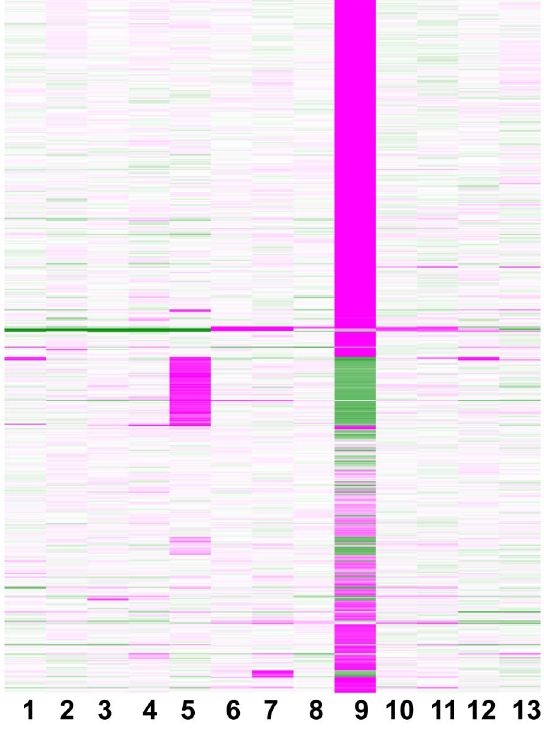
Figure 7. Transcript profiles of expressed Medicago DEFLs . Treatments were: (1) Germinating seed, (2) stem, (3) flower buds, (4) flowers, (5) seed, (6) uninoculated root for mycorrhizal control, (7) mycorrhizal root, (8) uninoculated root for nodule control, (9) nodules at 14 dpi, (10) P. medicaginis mock-inoculated root, (11) P. medicaginis - inoculated root, (12) C. trifolii mock-inoculated leaf, and (13) C. trifolii - inoculated leaf. The heat map shows median scaling of SBQ normalized signal intensity values as described in materials and methods and colors represent high transcript abundance as depicted in Figure 4.